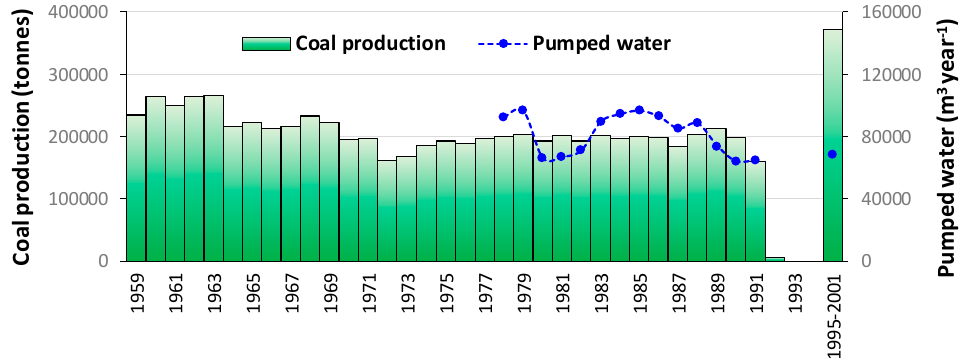
Figure 2. Majority coal production and pumping rate of the Lieres mine.